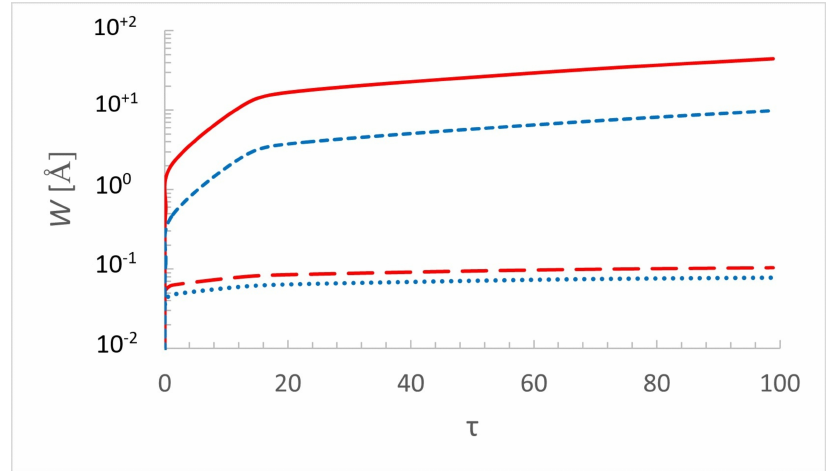
Figure 3. Same as in Figure 1 but for the atmosphere of a DO white dwarf. The atmosphere model from [38] with parameters T ef f = 60,000 K and log g =